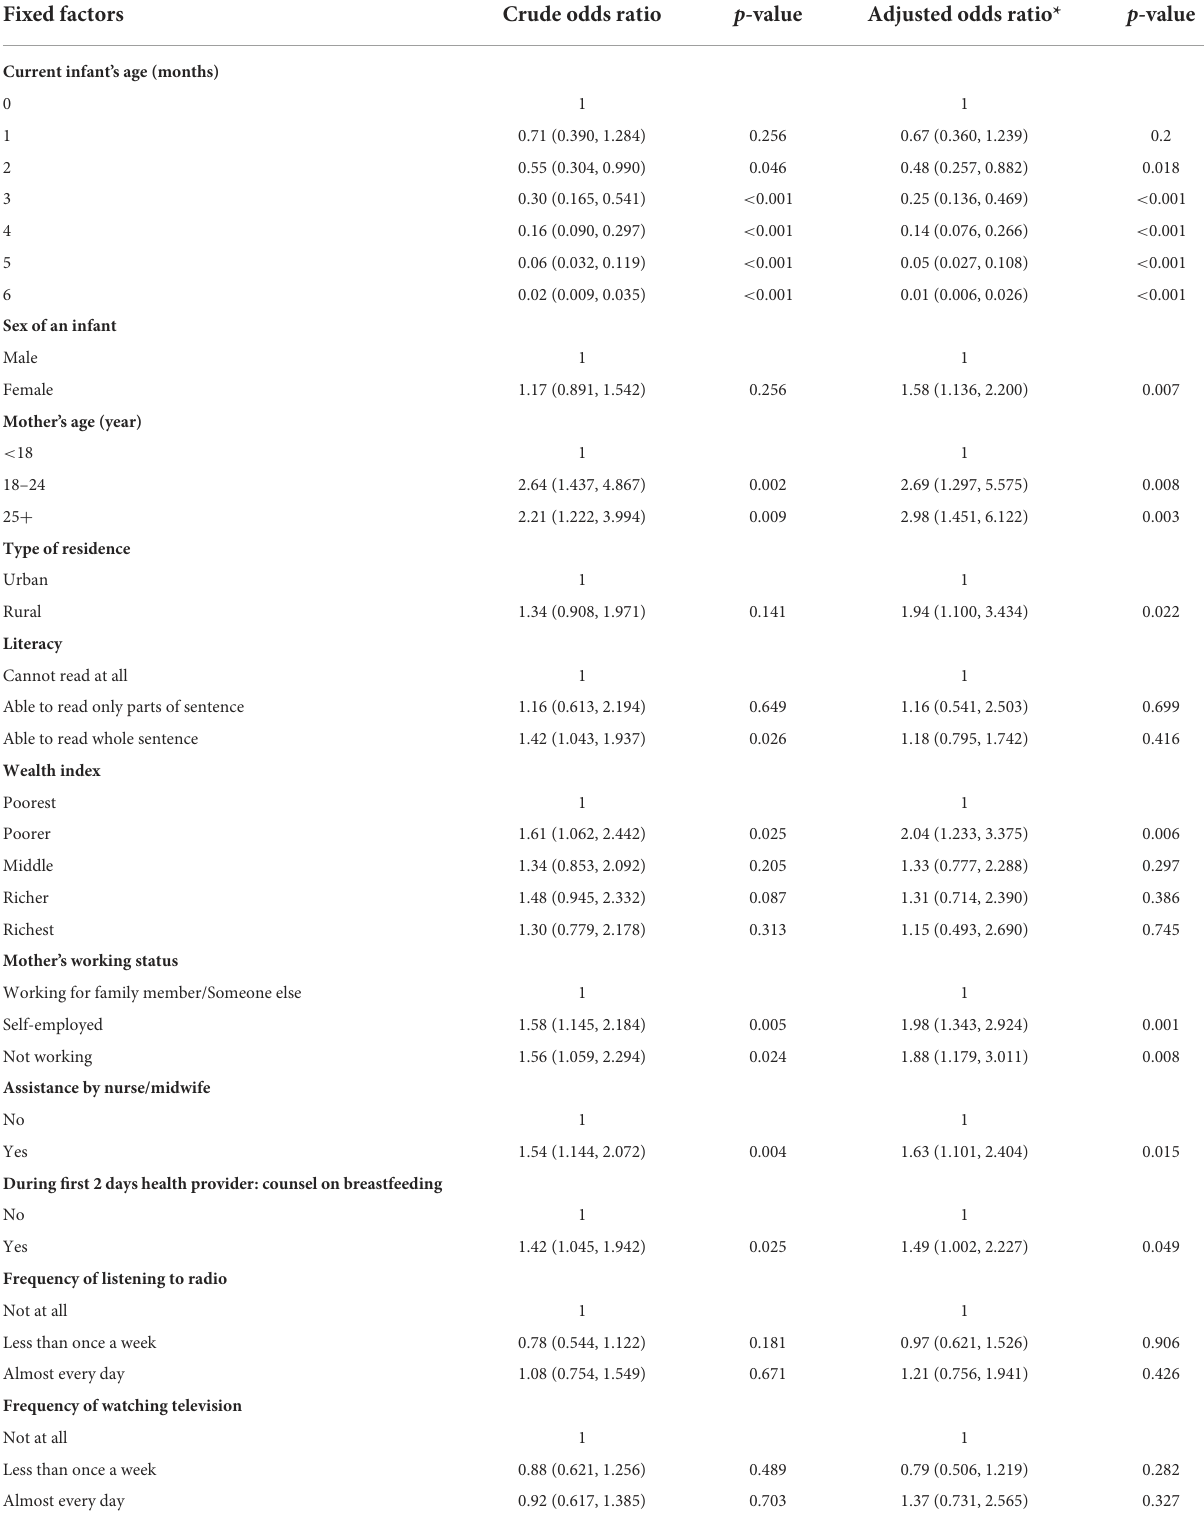
TABLE 2 Factors associated with exclusive breastfeeding with enumeration areas nested in regions as random factors. Fixed factors Crude odds